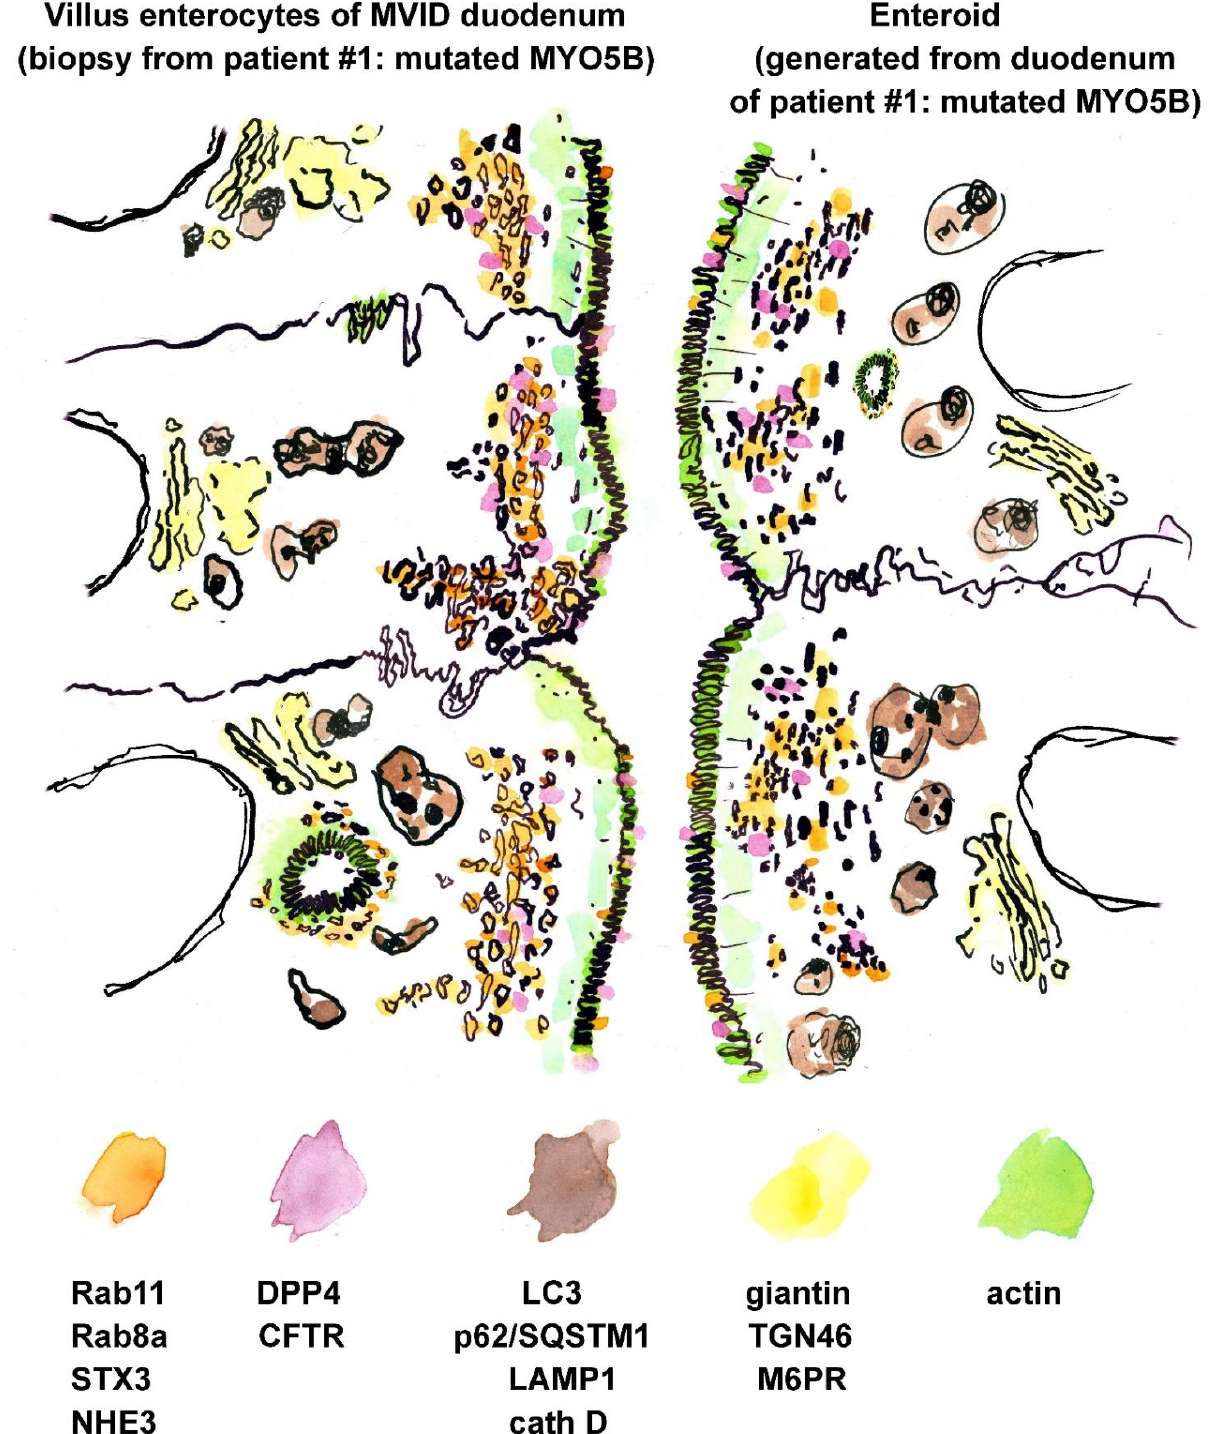
Figure 4. Synoptic illustration of immuno-gold and ultrastructural characteristics of duodenal biopsies and enteroids from MYO5B-PFIC patient #1. Compare this particular case with a respective synopsis of multiple MVID cases in Figure 2 of Ref. [10]. Drawing almost to scale. See also Supplementary Material Table S1.